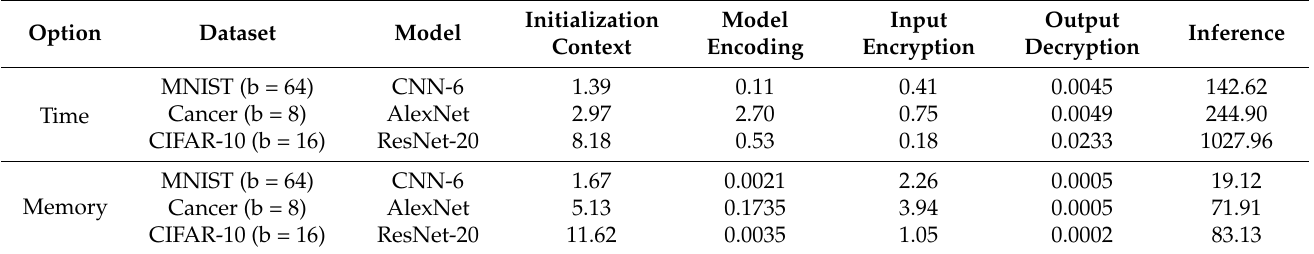
Table 5. Ciphertext inference time (s) and memory usage (GB) consumption.